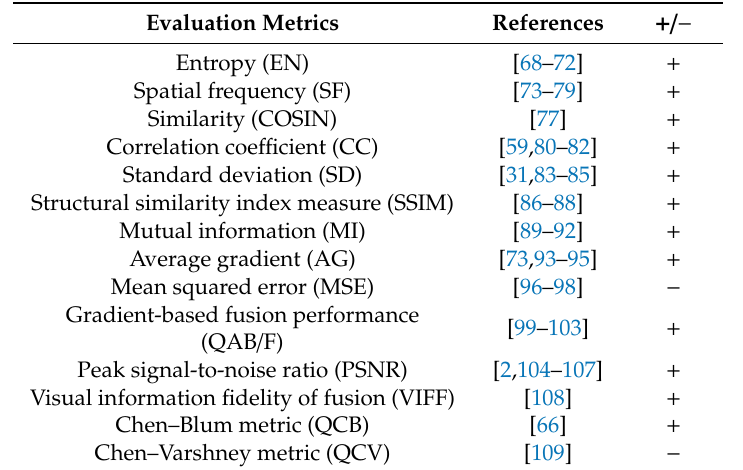
Table 5. Statistics of some representative fusion evaluation measures and references. “ + ” means that a large value indicates good performance, while “ − ” means that a small value indicates good